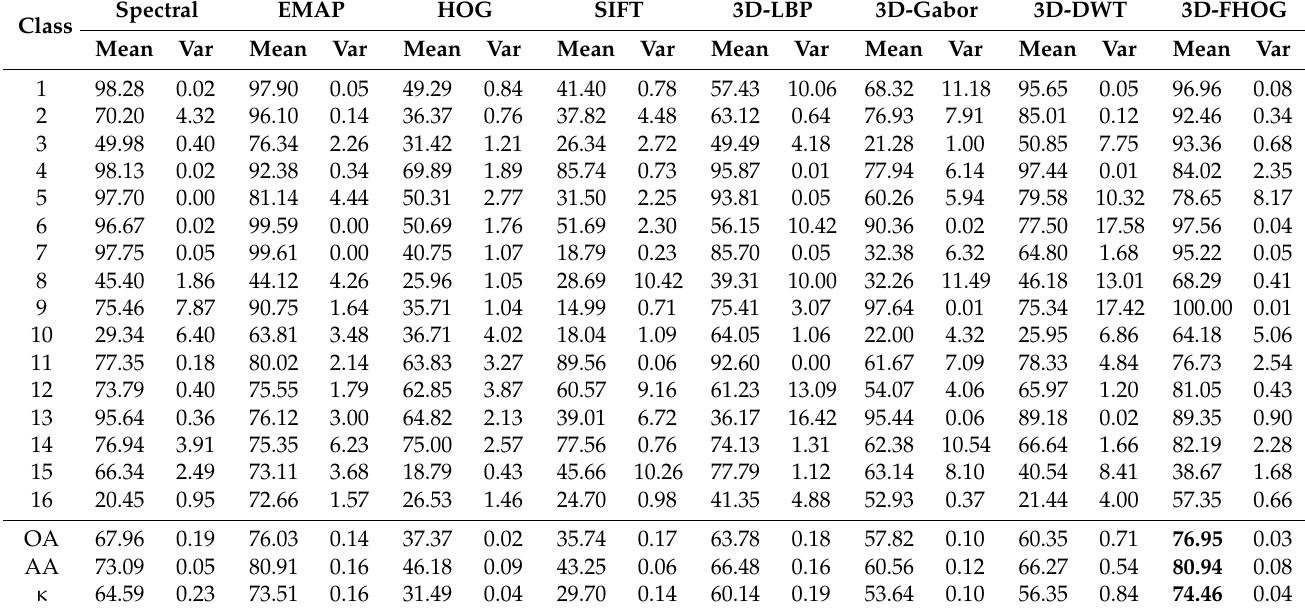
Table 7. Classification results (%) for Spectral, EMAP, HOG, SIFT, 3D-LBP, 3D-Gabor, 3D-DWT,